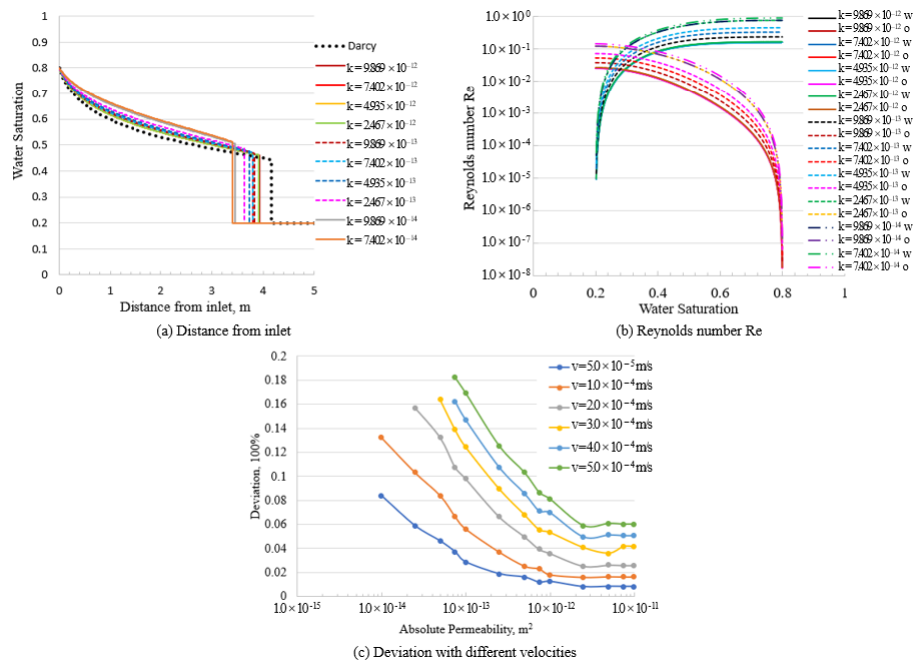
Figure 13. Comparison of Darcy model versus Barree – Conway model for different flow velocities.